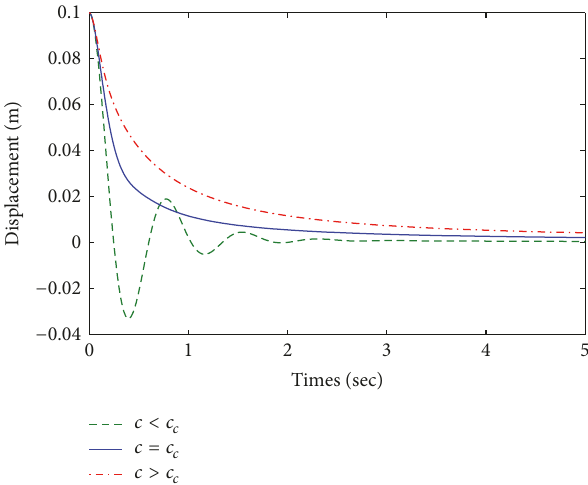
Figure 2: When 𝛼 = 9/11 , the three cases of free decay vibration.